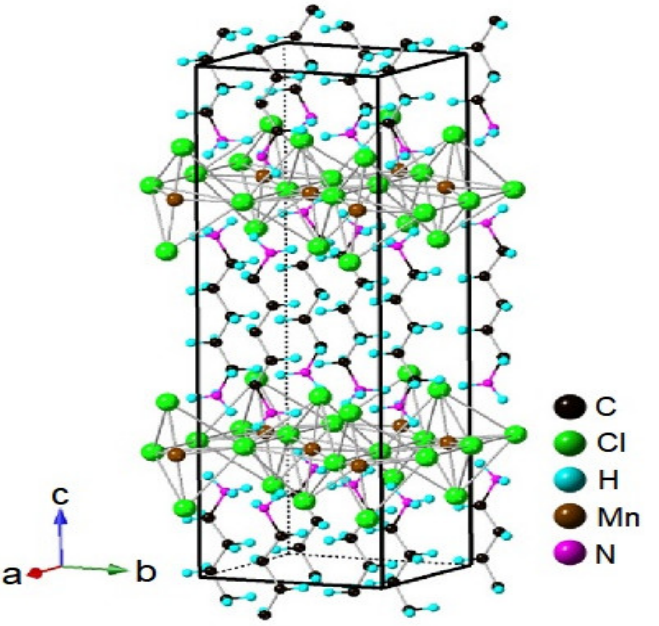
Figure 1. Orthorhombic structure of a [NH 3 (CH 2 ) 5 NH 3 ]MnCl 4 crystal at 298 K [23].